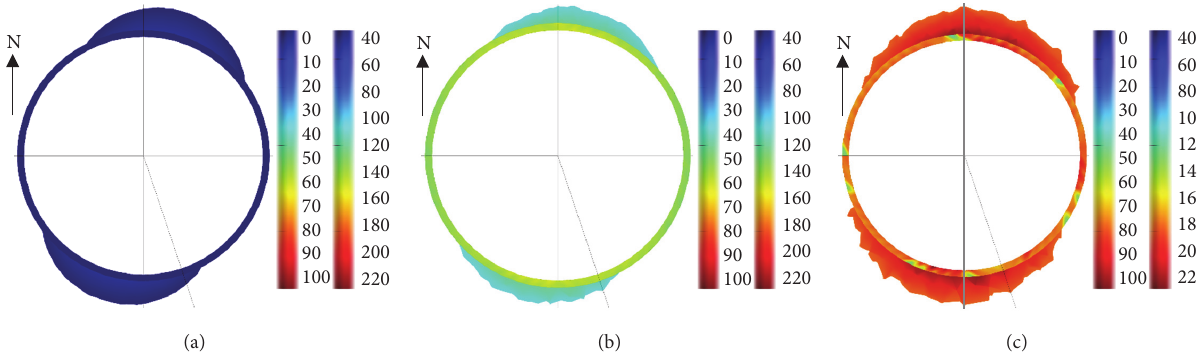
Figure 14: First principal stress [MPa] at − 3m level resulting from (a) 0 weeks in situ stress, (b) 9 weeks of heating, and (c) 16 weeks of heating using the ONK-EH3 stress interpretation. The left scale is for the concrete and the right scale is for the surrounding rock